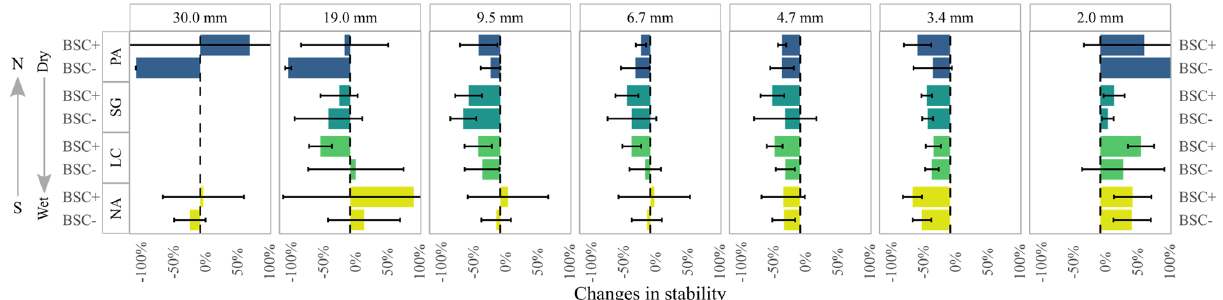
Figure 4. Mean and standard deviation of aggregate size distribution changes between dry and wet sieving for the sites Pan de Azúcar (PA), Santa Gracia (SG), La Campana (LC), and Nahuelbuta (NA) for biocrust (BSC + ) and non-biocrust (BSC − ) treatments. Error bars were, in some cases, truncated for better visualization.